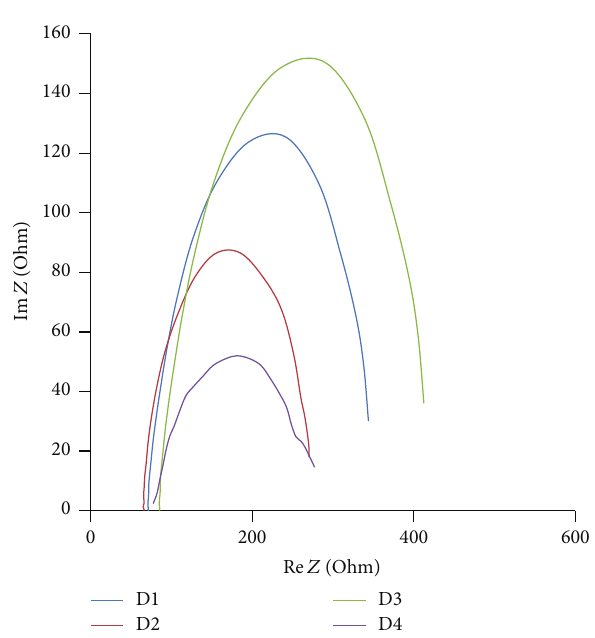
Figure 5: Nyquist plots of the